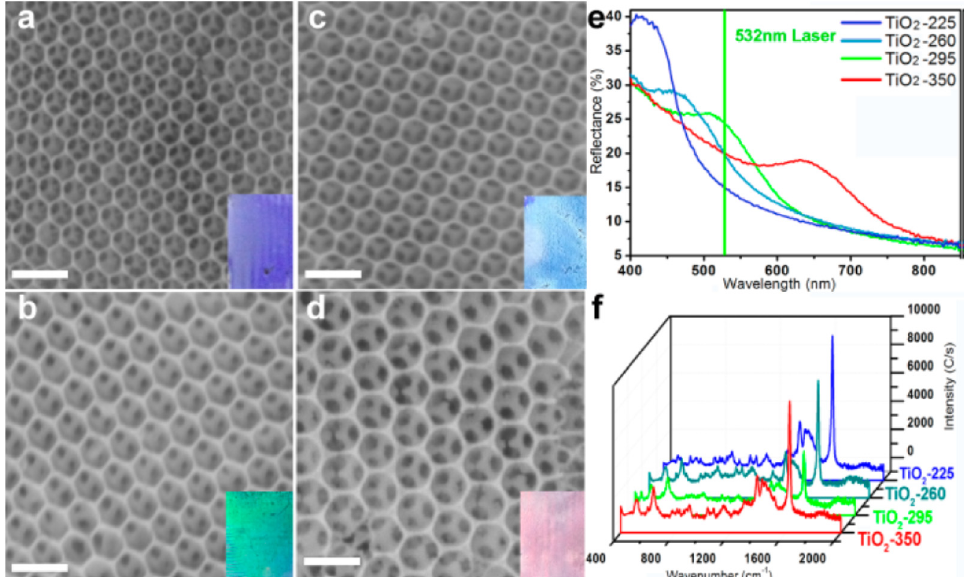
Figure 11. ( a – d ) SEM images of TiO 2 inverse opal substrates calcined in various temperatures: ( a ) 225, ( b ) 260, ( c ) 295, ( d ) 350 °C. ( e ) Reflection spectra of TiO 2 inverse opal substrates. ( f ) SERS spectra of methylene blue adsorbed from 10 − 5 M aqueous solution on various inverse opal substrates. Reprinted with permission from [53]. Copyright 2014 American Chemical Society.